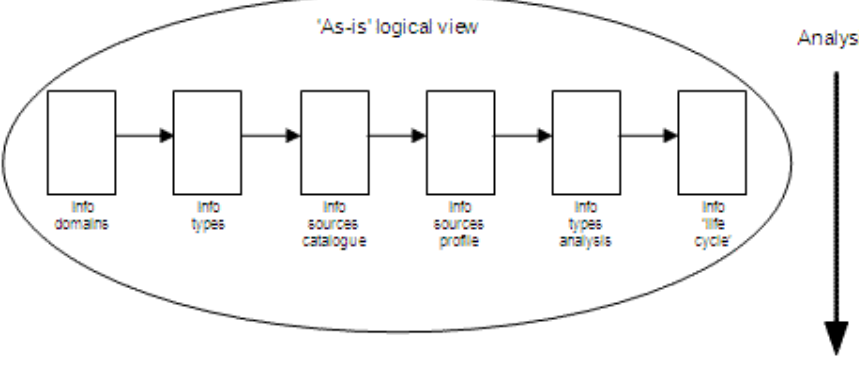
Figure 2 Analysis step (adapted from Fisher 2004:7)